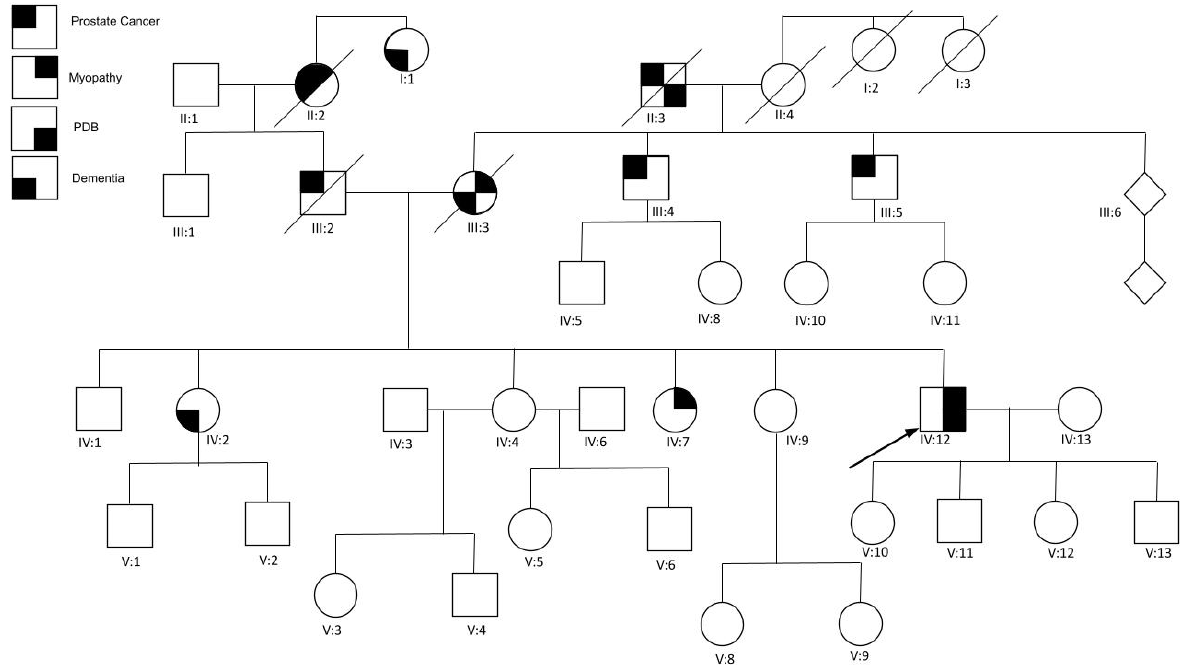
Figure 3. Pedigree of family 2. The proband (IV:12) is indicated by the arrow. Plain radiographs showed thickened trabeculation with increased sclerosis of the T11 and T12 vertebral bodies consistent with Paget changes. There was also a mild degenera- tive disc disease at the thoracolumbar junction and fusion of the sacroiliac joint inferiorly. The CT showed an abnormal bone matrix of T11 and T12 vertebral bodies and posterior elements, highly suspicious for Paget’s disease. Ultrasound of the thyroid showed a left solitary nodule highly suggestive of chronic thyroiditis. MRI scans showed mild edema of the right vastus lateralis and medialis muscles, bilateral biceps femoris, and bilateral posterior compartment musculature. In addition, generalized fatty muscle atrophy was observed with advanced atrophy on the left vastus medialis, moderate atrophy involving the right posterior compartment and bilateral gluteus minimus muscles, and mild atrophy on the bilateral tensor fascia lata. Given the combination of PDB and myopathy, a comprehensive neuromuscular dis- ease NGS gene panel and deletion/duplication analysis were performed, which revealed a novel variant c.478 G>A that resulted in the protein substitution of alanine with threo- nine at position 160 ( p.A160T) in the VCP gene. Subsequently, whole exome sequencing was conducted, which did not reveal any additional pathogenic variants. The proband’s mother (III:3) was diagnosed with IBM in her 5 0s, with rimmed vacu- oles noted in her muscle biopsy. She also had delayed responses in conversations and confusion about her personal location later in her life, suggestive of dementia. She died at 72 years of age from recurrent aspiration and pneumonia. The proband’s father (III:2) had metastatic thyroid cancer. The proband has a 54 year old sister (IV:2) with unilateral reti- noblastoma, thyroid cancer, anxiety, depression, and progressive memory loss at 52 years and was later identified with the familial VCP variant. She has been diagnosed with FTD and muscle weakness, and also has bone pain. No imaging or further testing was reported. A 48 year old sister (IV:7) with muscle weakness and Hashimoto’s disease also tested pos- itive for the familial variant, and a 46 year old sister (IV:9) was determined to be a noncar- rier after genetic testing. The other siblings (IV:1 and IV:4) have not been tested for this mutation. Mixed European and Ashkenazi Jewish heritage is reported on both sides of the family.